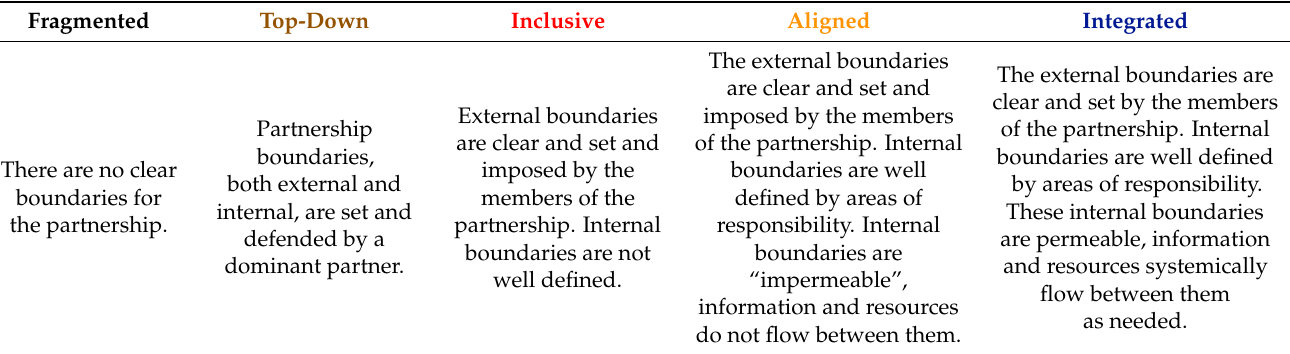
Table 3. The five cooperative capacity states’